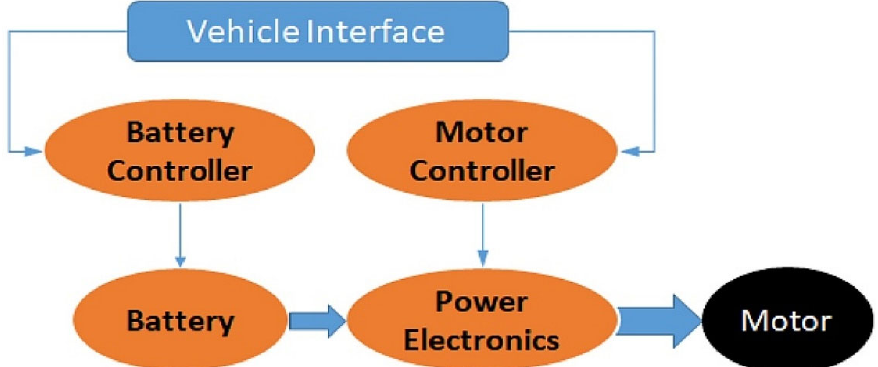
Figure 8. Block diagram of the electric vehicle drive system.